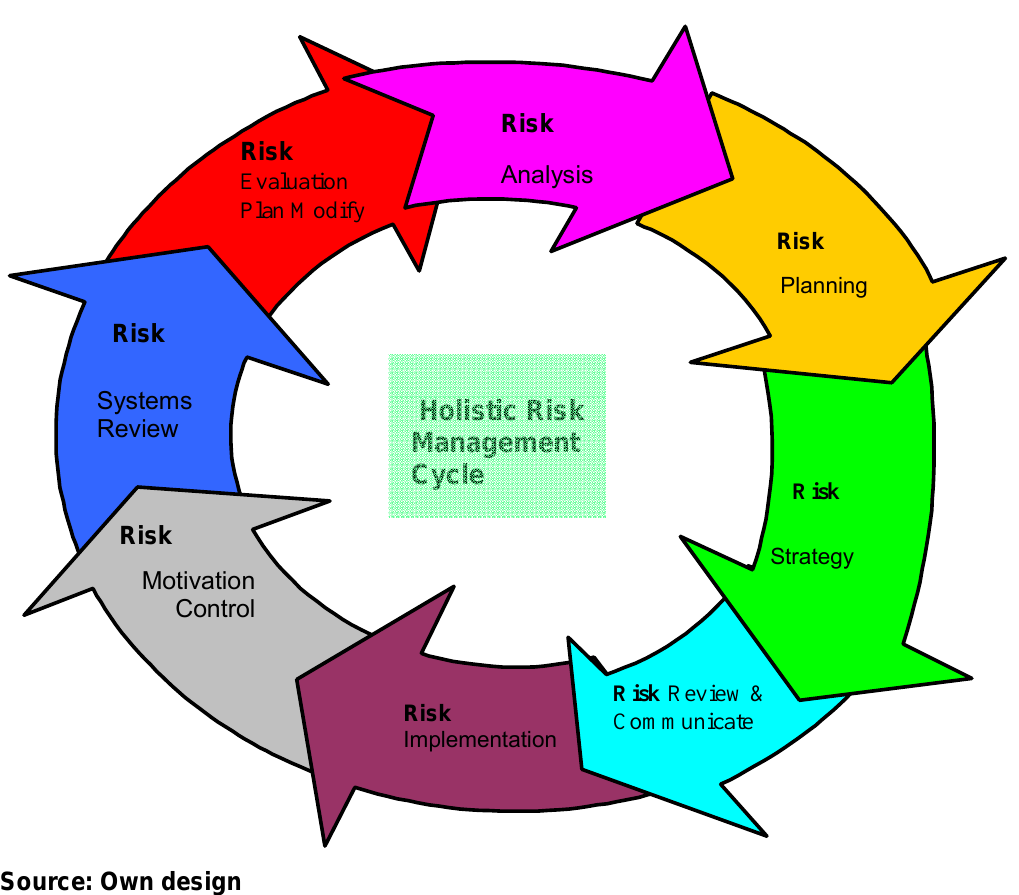
Figure 5: Proposed holistic risk management